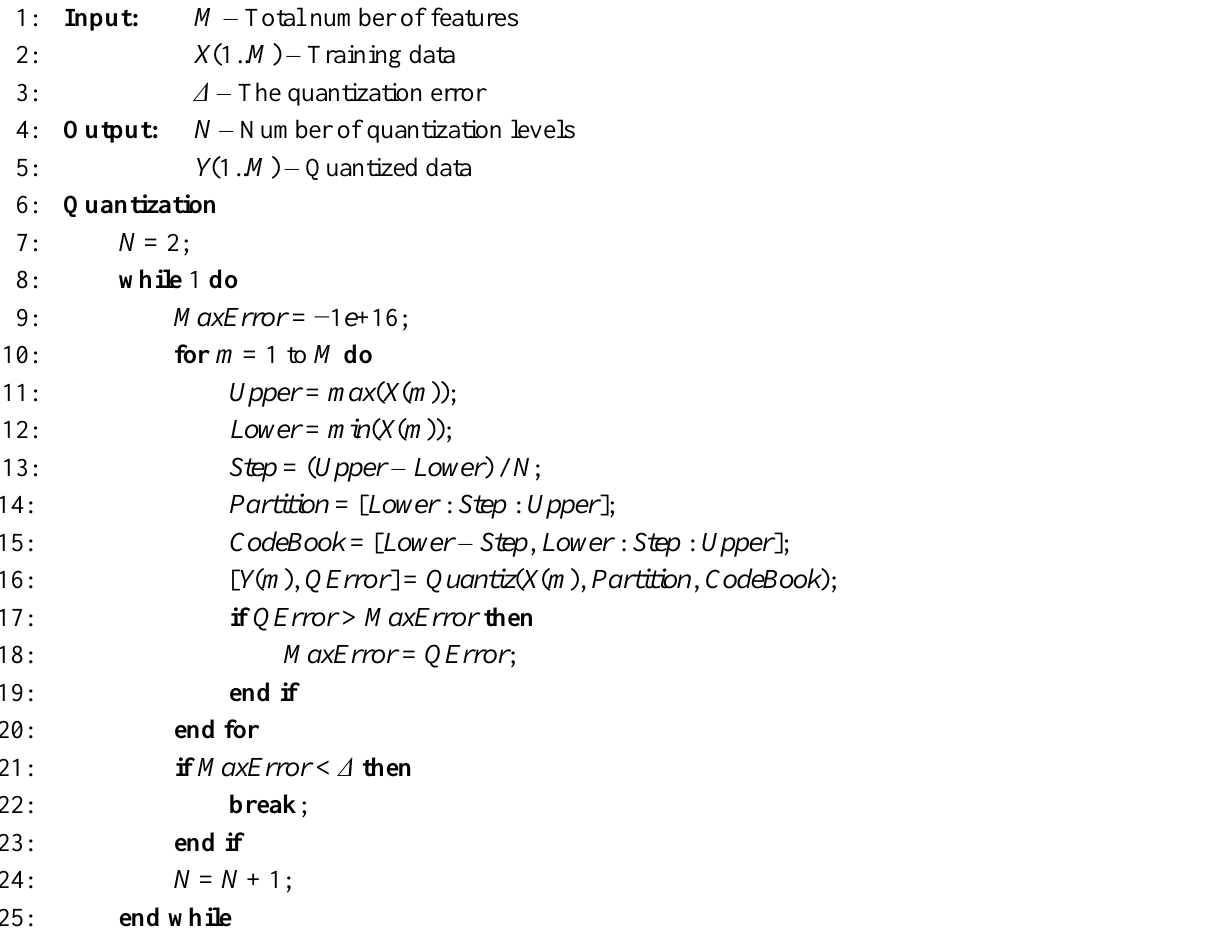
Algorithm 1. Feature